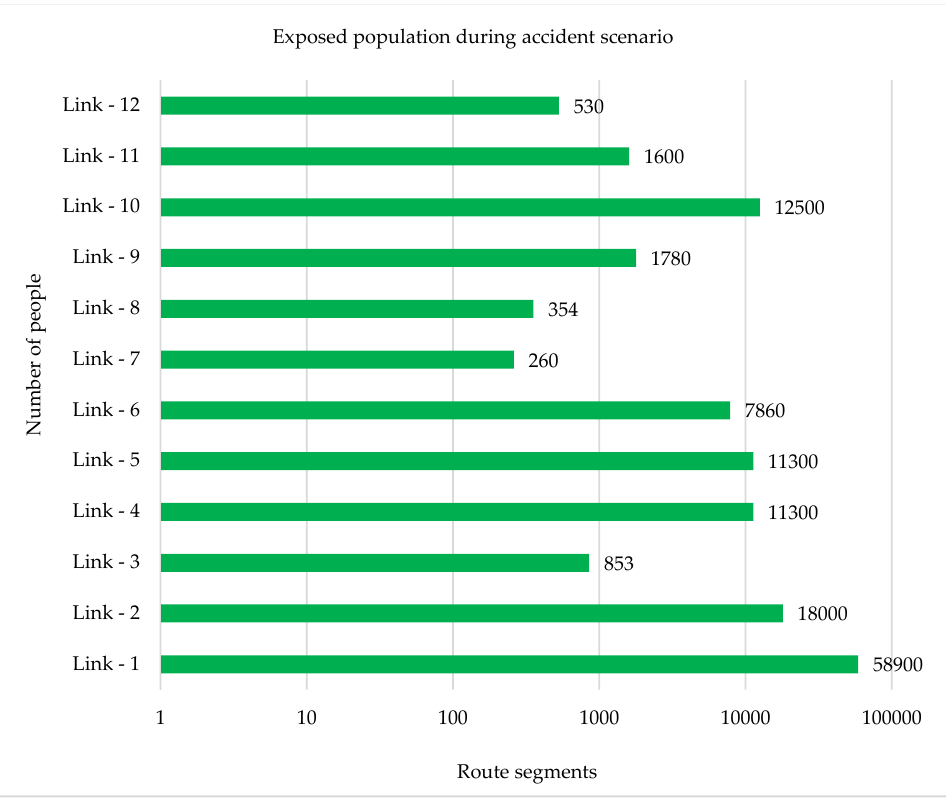
Figure 5. Exposed population in route segments (links) during accidents.